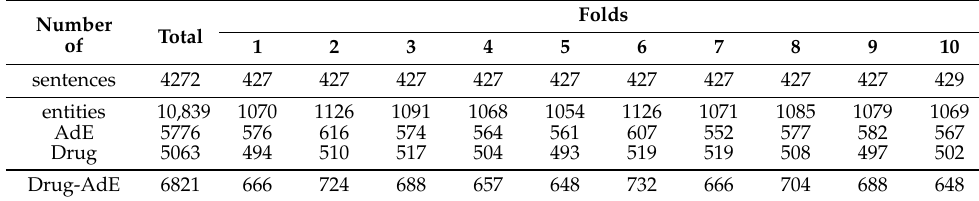
Table 3. ADE dataset